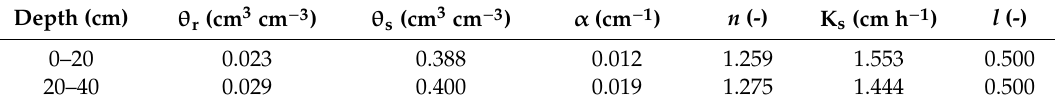
Table 3. Soil hydraulic parameters obtained with HYPROP +